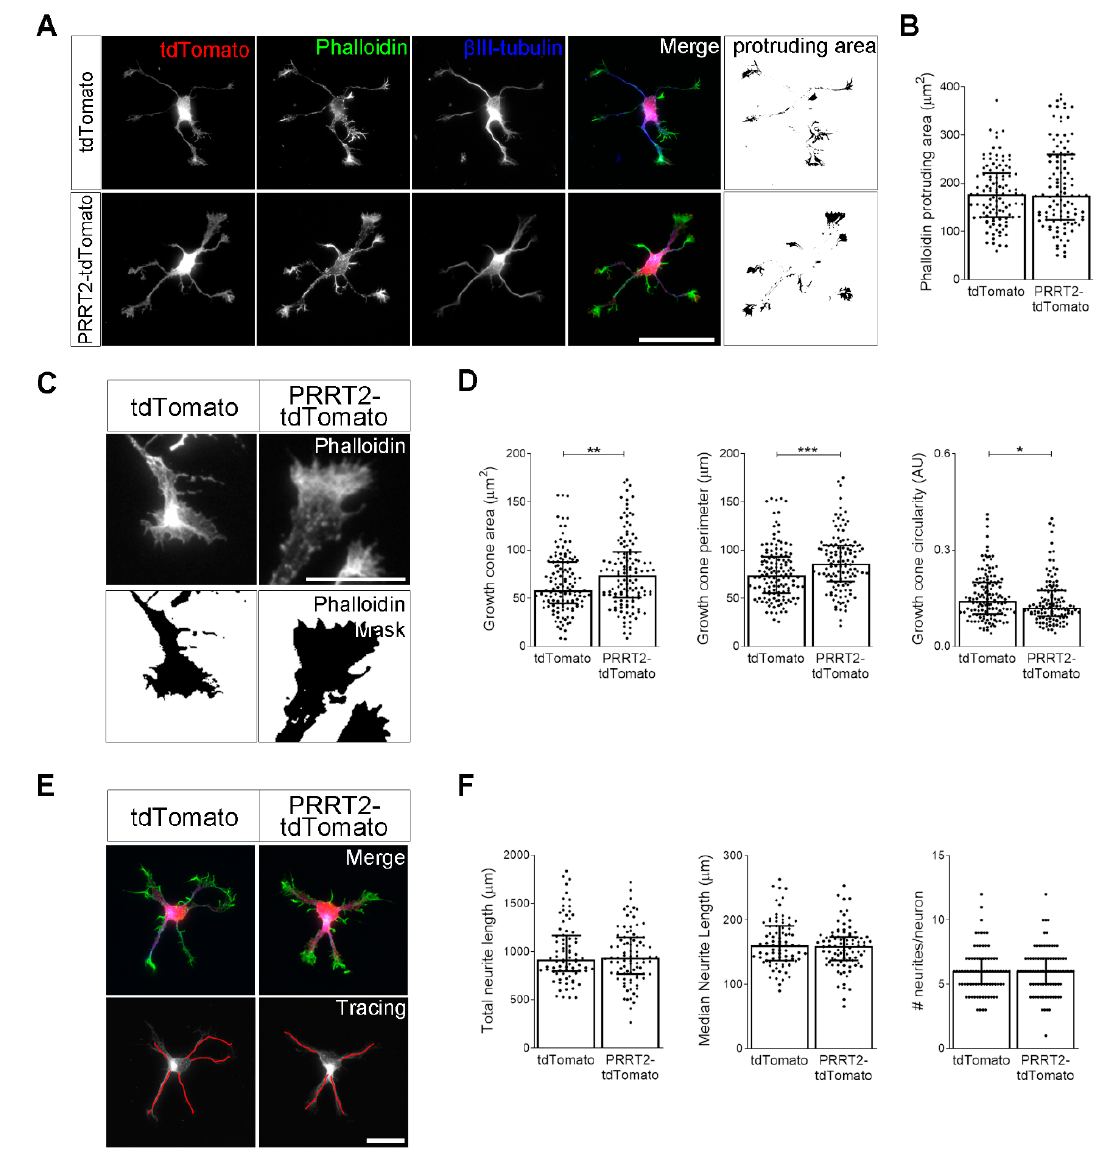
Figure 2. PRRT2 overexpression in developing hippocampal neurons increased growth cone dimension and complexity. ( A ) 1 DIV embryonic hippocampal neurons electroporated at 0 DIV with tdTomato or PRRT2-IRES-tdTomato.